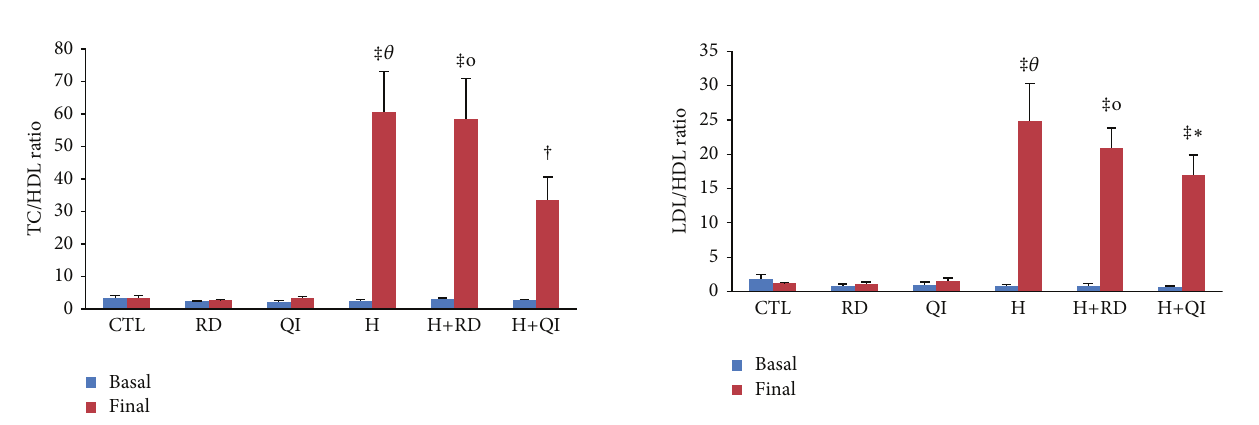
Figure 1: The basal and final values of plasma atherogenic index (total cholesterol to HDL cholesterol ratio, TC/HDL ratio) of the animal groups. The values are Mean ± SEM. 𝑛 = 6 ; CTL: control; RD: Rosa damascena L.; QI: Quercus infectoria ; H: Hyperlipidemic; H+RD: Hyperlipidemic+RD; H+QI: Hyperlipidemic+QI. ‡ 𝑃 < 0.001 compared with the related basal value; 𝜃 𝑃 < 0.001 compared with the final values of the CTL, RD, and QI groups, o 𝑃 < 0.001 compared with the final values of the RD and CTL; † 𝑃 < 0.05 compared with the related basal value.